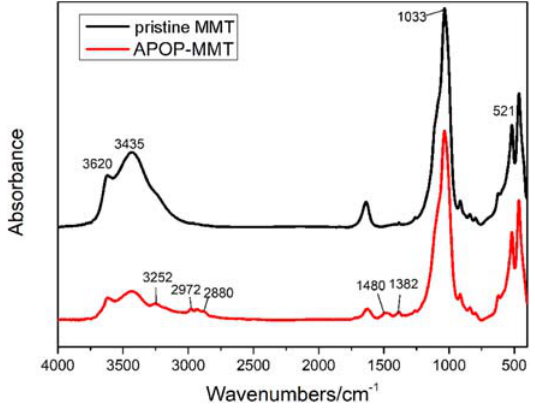
Figure 4: FTIR spectra of pristine MMT and APOP -